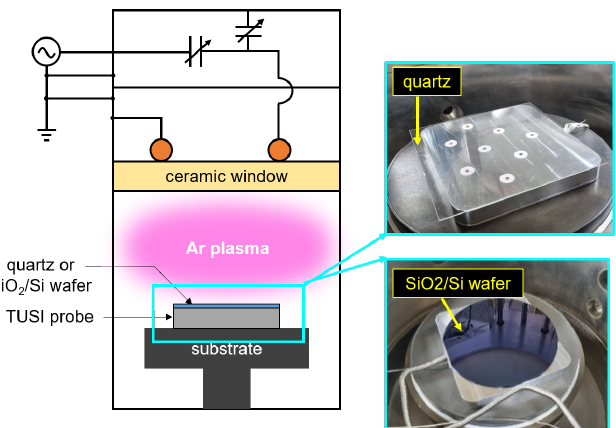
Figure 6. Schematic diagram and photographs of the experiment setup for the demonstration of the TUSI probe beneath a quartz and a SiO 2 (100 nm)/Si